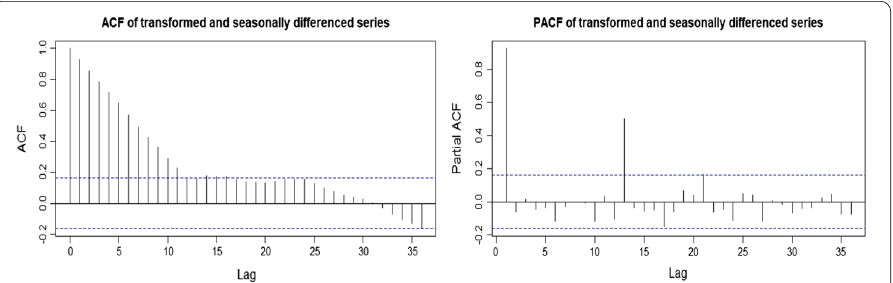
Fig. 4 Plot of autocorrelation and partial autocorrelation of transformed and seasonally differenced gold futures price